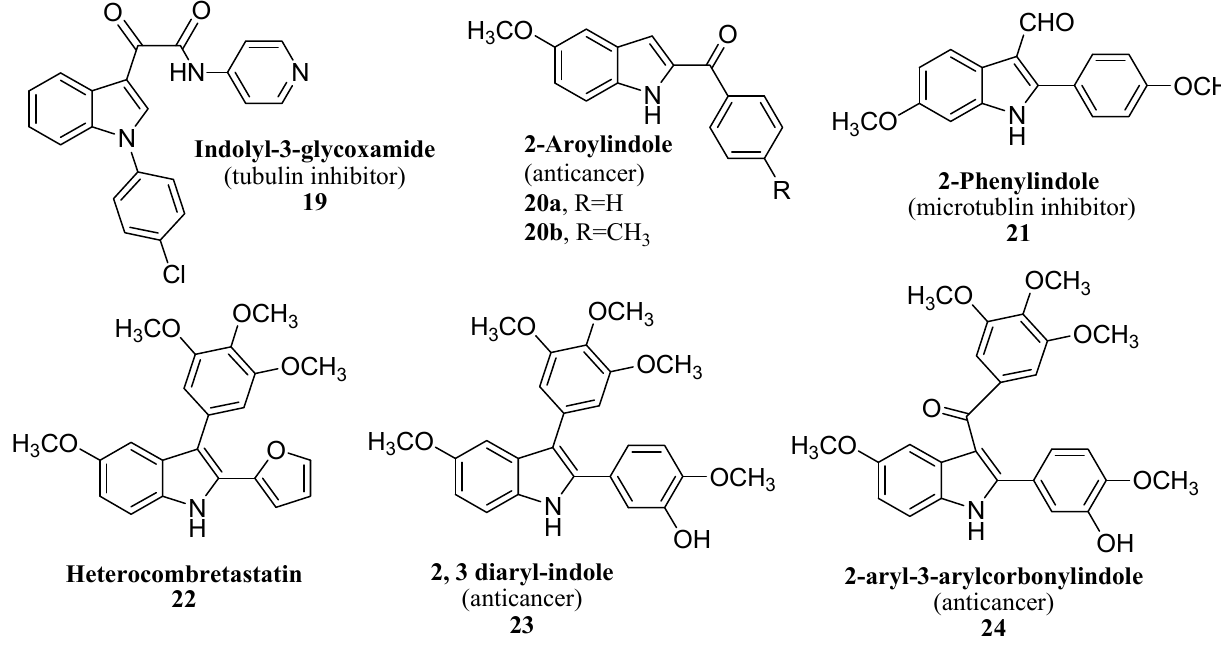
Figure 6. Indole derivatives as tubulin